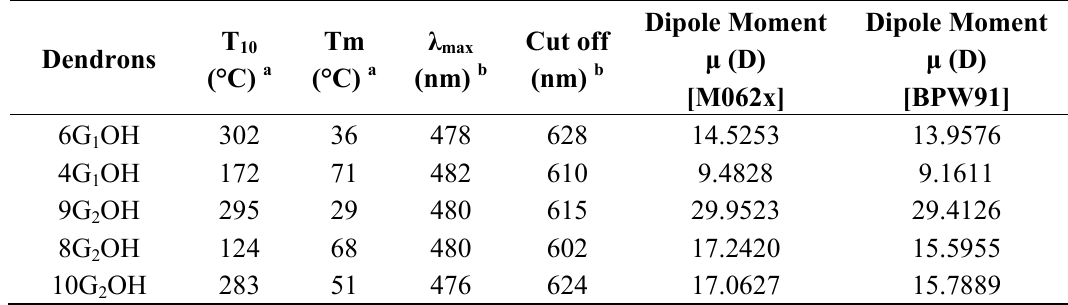
Table 1. Thermal and optical properties of the dendrons.